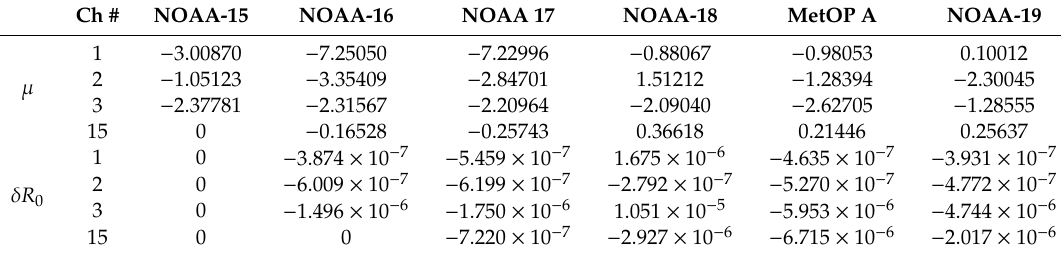
Table 5. Calibration coe ffi cients for AMSU-A Channels 1–3 and 15 a